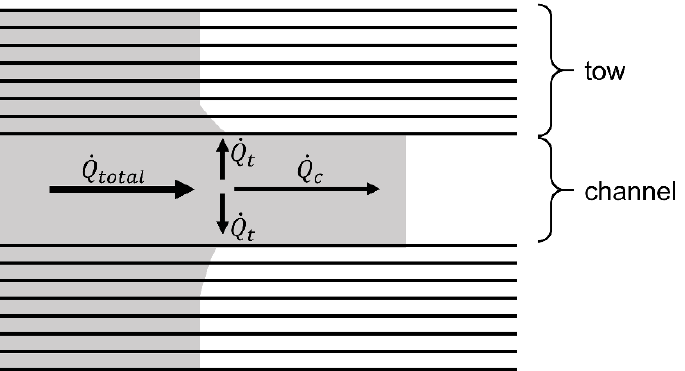
. Q t into the tow and longitudinal flow